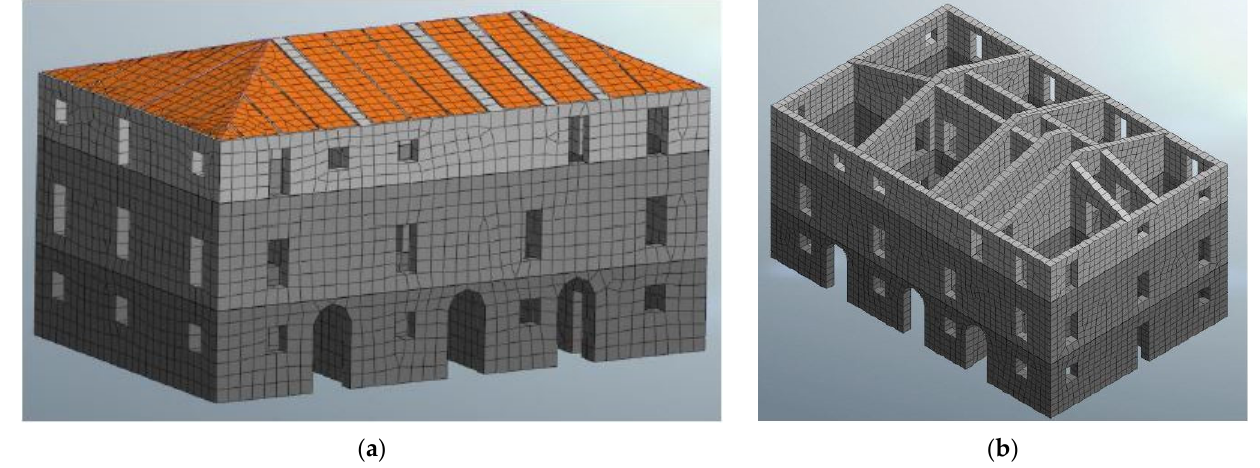
Figure 13. ( a ) Finite element model implemented using MIDAS FEA software; ( b ) Mesh.